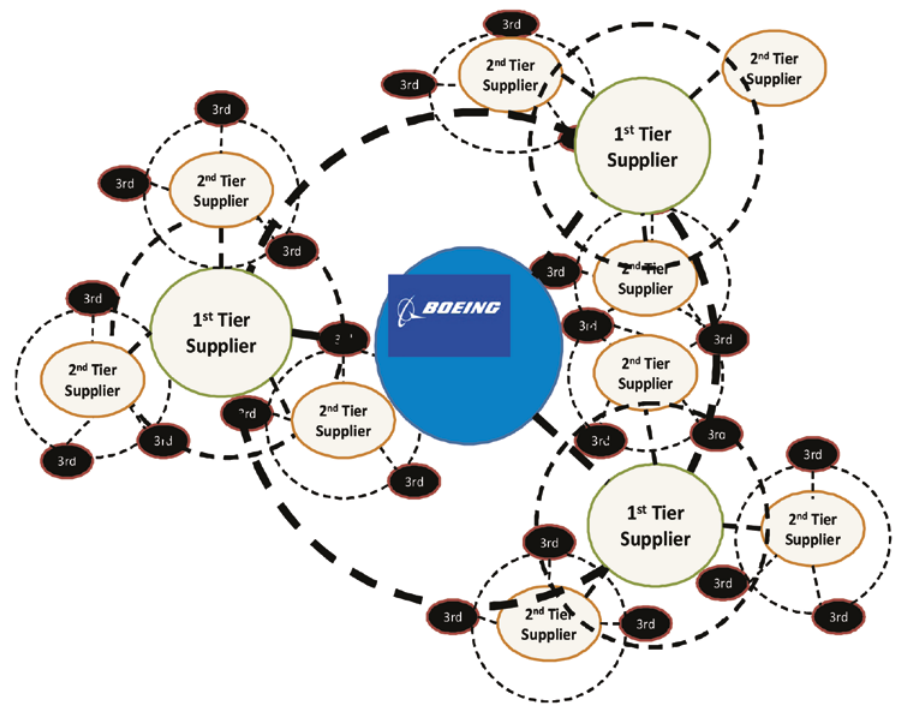
Figure 6: An unconventional illustration of a supply chain by interpreting Boeing’s 787